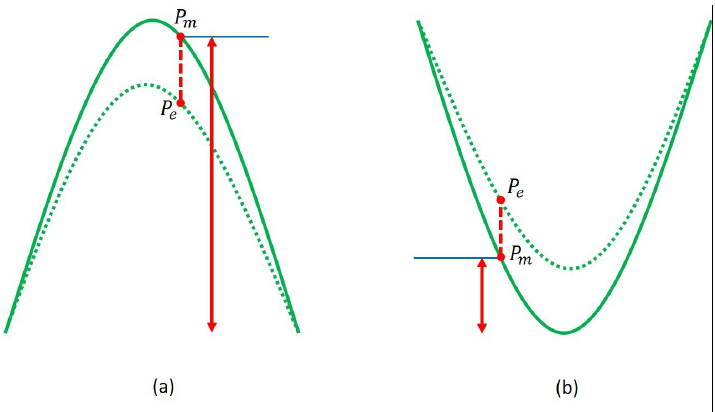
Figure 19. The difference errors between the high and low values: ( a ) Error value when measured data is high; ( b ) Error value when measured data is low. Table 9. The error values between the estimated and real